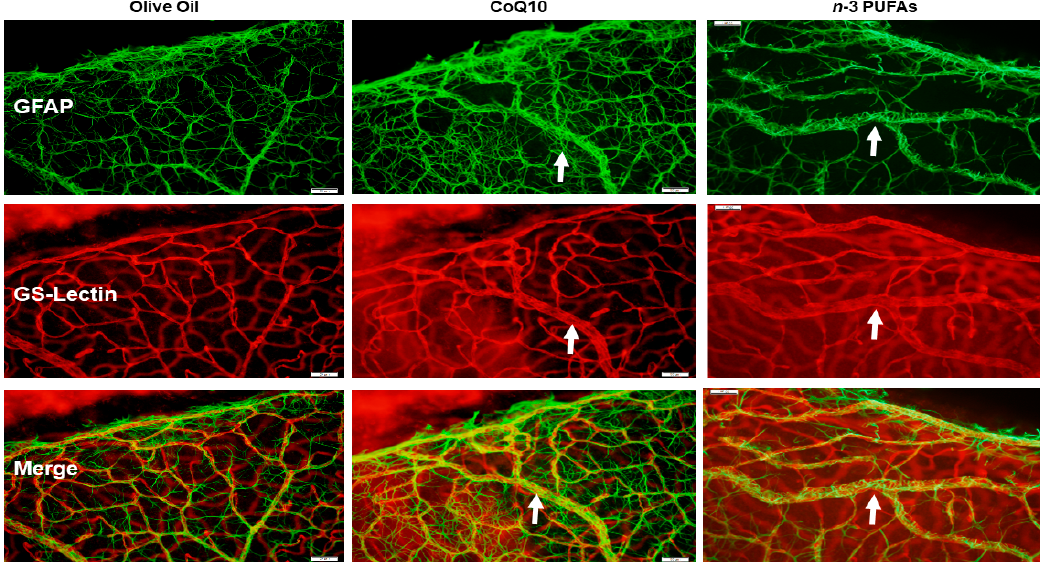
Figure 5. Representative images of retinal flatmounts from 21-day-old rat exposed to RA. Astrocytes and Müller cells were stained for glial fibrillary acidic protein (GFAP) immunoreactivity (green), and retinal vasculature was stained with isolectin B4, which is a biomarker for endothelial cells (red). Merged images are presented in the bottom panel. The white arrows in the CoQ10 and n -3 PUFA groups show mild vessel dilation at the periphery. Animals were supplemented with olive oil ( left panels ), CoQ10 ( middle panels ), or n -3 PUFAs ( right panels ). Images are 10× magnification, and the scale bar is 100 µM.